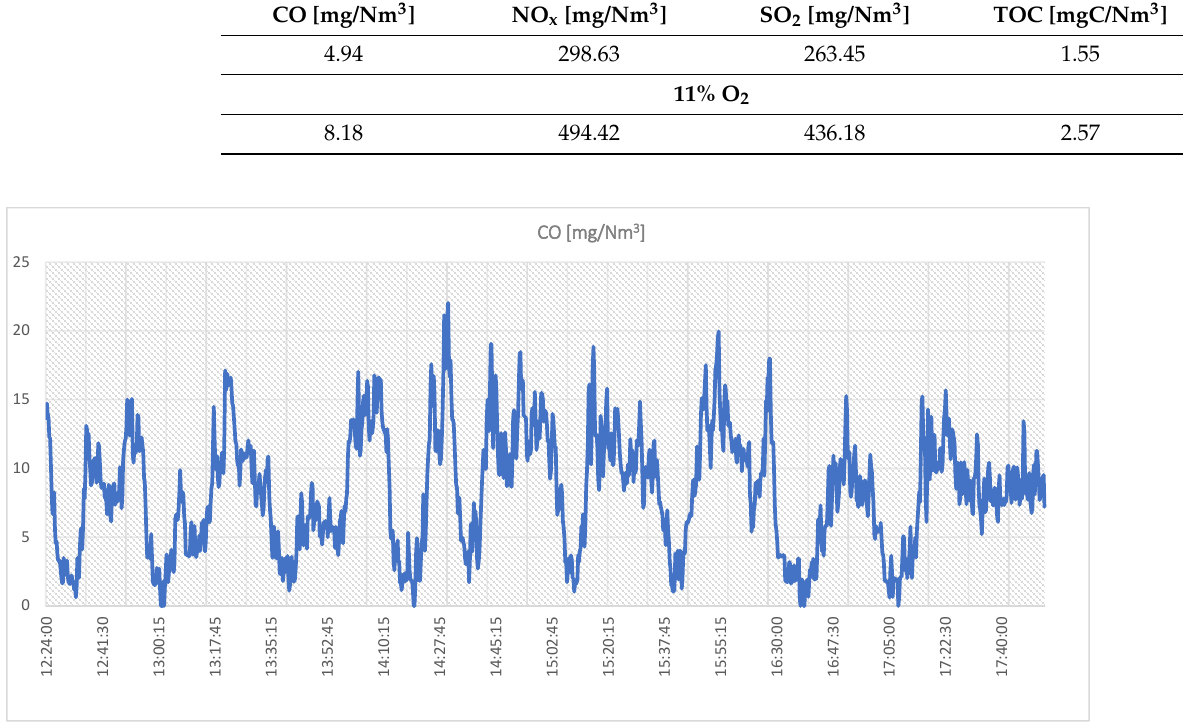
Figure 4. NOx emission trend during combustion test.